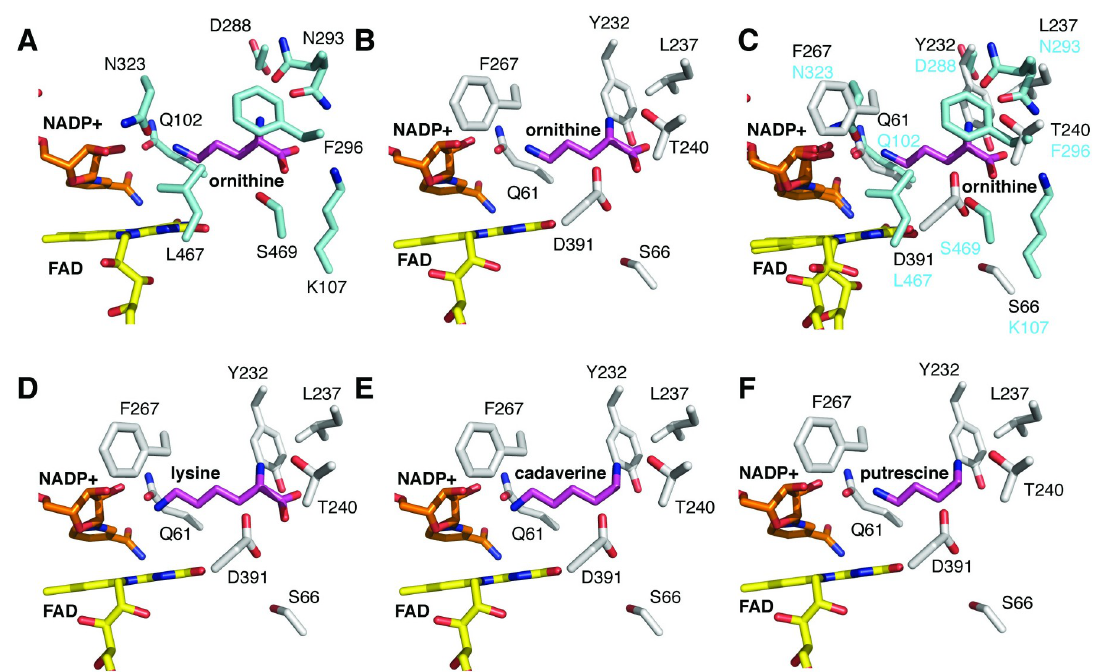
Fig 12. Structural analysis of substrate specificity. A. Active site structure of SidA bound to NADP + and ornithine (PDB code: 4b63). B. Model of ornithine binding to the active site of Ss DesB obtained by superimposing the coordinates of Ss DesB (PDB code: 6XBB) onto the coordinates of SidA bound to ornithine (PDB code: 4b63). C. Comparison of the active site environment between Ss DesB and SidA. D. Modeling of lysine binding to Ss DesB. E. Modeling of cadaverine binding to Ss DesB. F. Modeling of putrescine binding to Ss